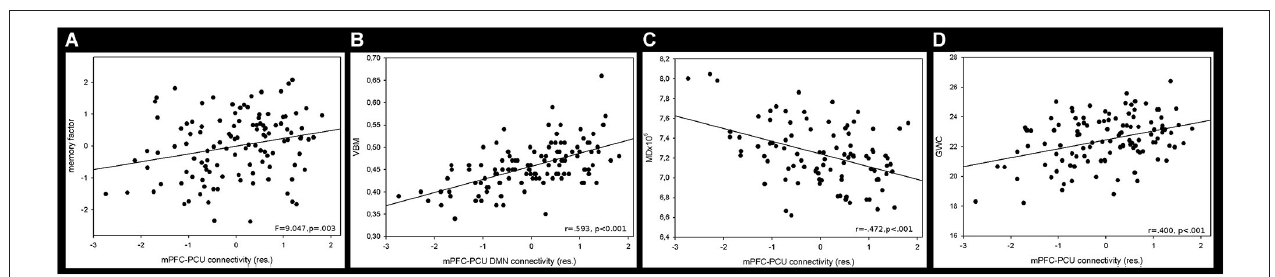
FIGURE 4 | Relationship ( p < 0.05; FWE corrected) between mPFC-PCU DMN connectivity and (A) GWC (B) VBM and (C) MD . Positive relationships are shown on a Red-Yellow scale and negative relationship on a blue-lightblue scale. Both VBM and CTh showed a positive correlation with DMN connectivity, thus indicating preserved GM integrity with higher connectivity values. Mean Diffusivity showed a negative relationship with